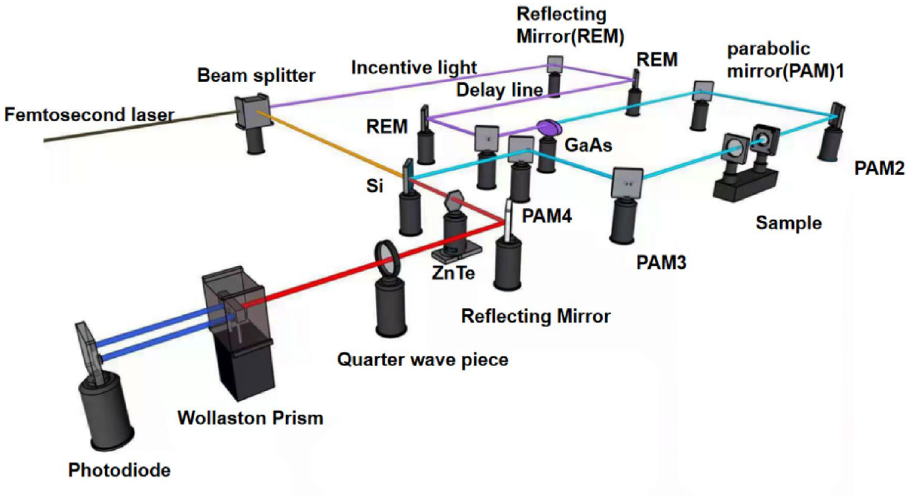
Figure 7. Schematic diagram of the transmission THz-TDS system. Incident and transmitted terahertz waves are shown with blue